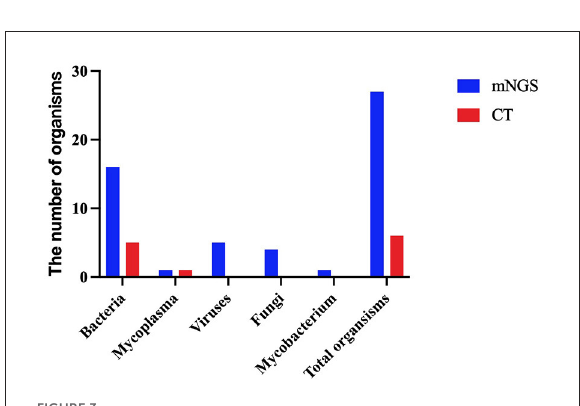
FIGURE3 A comparison of the type of organisms detected using the metagenomic next-generation sequencing (mNGS) and conventional tests (CT)